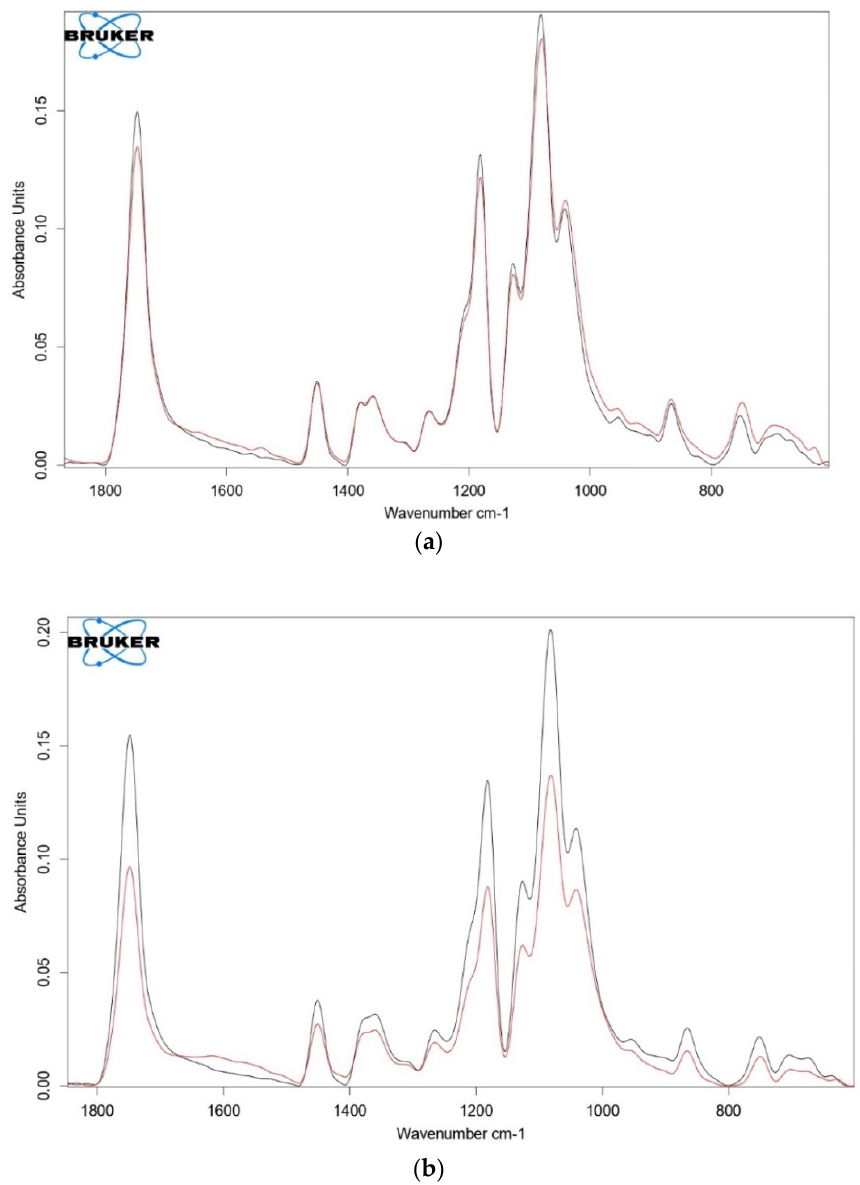
Figure 10. FTIR spectra of PLA ( a ) and PLA/NR fiber ( b ) with the NR content 10 wt.%: grey — before, red — after degradation in soil for 220 days.